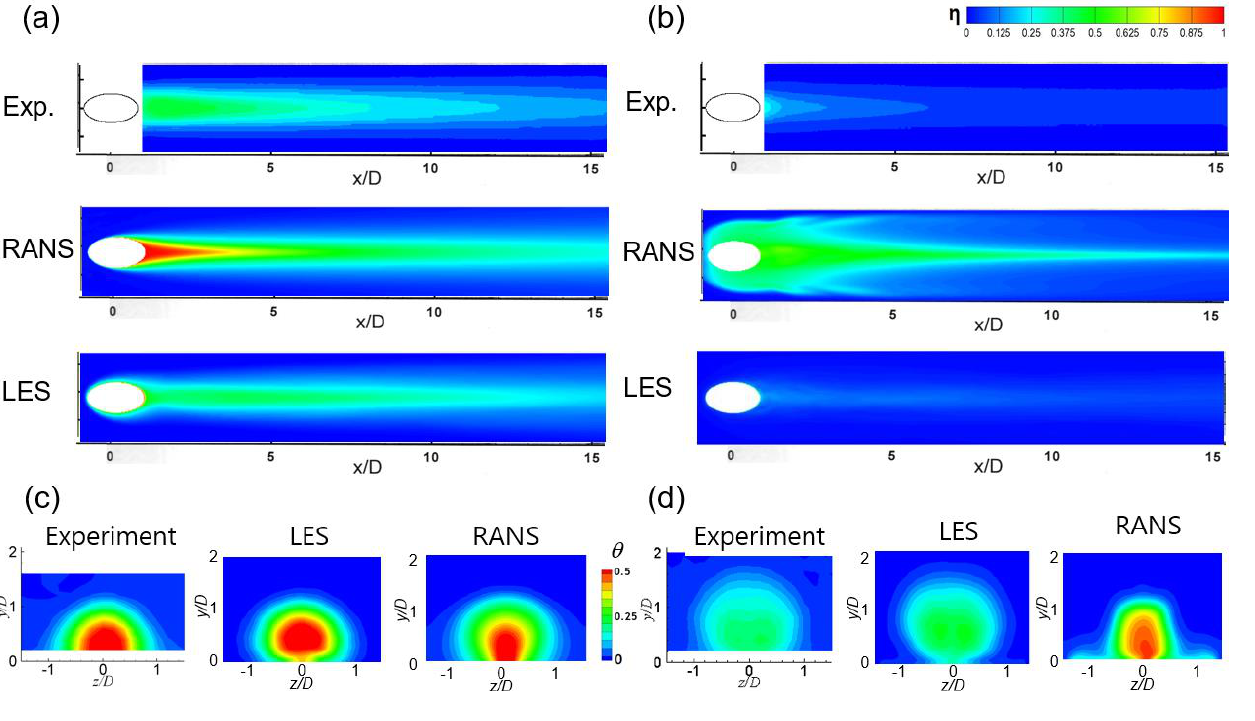
Figure 12. Film cooling with bulk-flow pulsation for M = 0.5 [76]: ( a ) effectiveness without pulsation, ( b ) effectiveness with pulsation, ( c ) boundary layer temperature at x / D = 2.5 without pulsation, and ( d ) boundary layer temperature at x / D = 2.5 with pulsation.